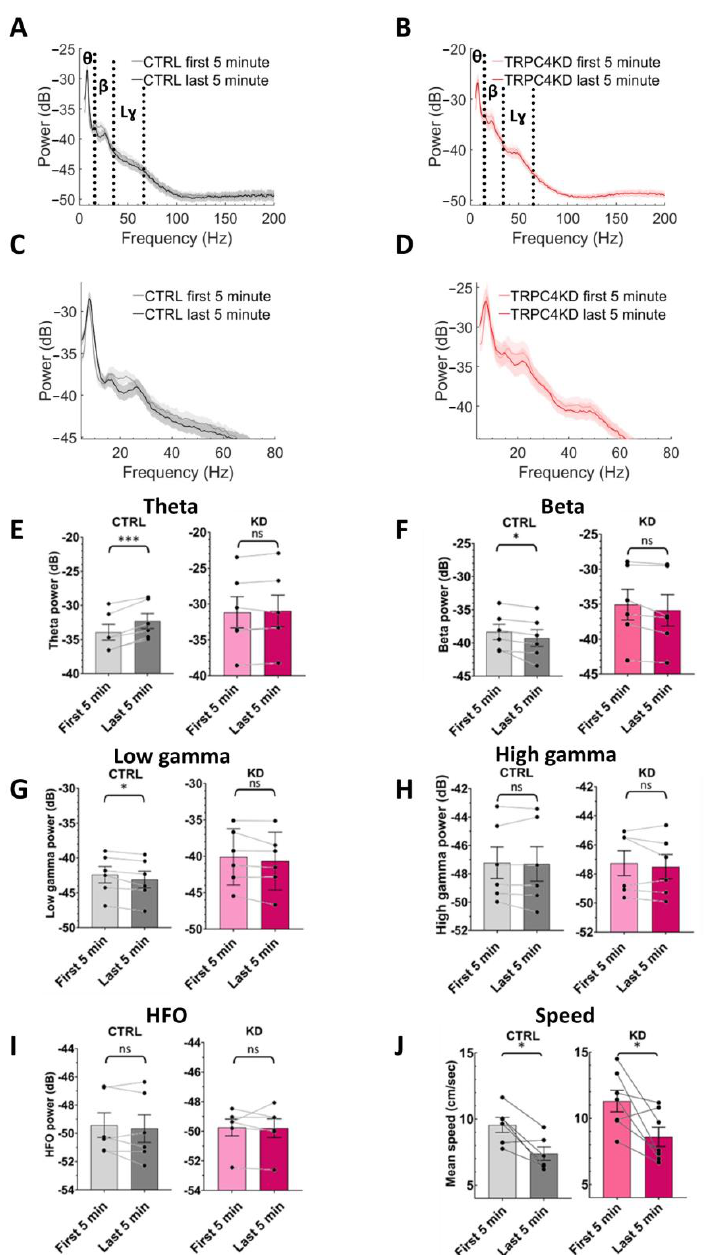
Figure 4. Comparison of the first and the last 5 min of the LT task. ( A ) Mean power spectra in the first 5 min and the last 5 min for scramble group. ( B ) Mean power spectra in the first 5 min and the last 5 min for TRPC4 KD group. ( C , D ) Rescaled power spectra shown in ( A , B ). ( E ) Theta oscillations (paired t -test, p < 0.001 for scramble and p = 0.305 for TRPC4 KD). ( F ) Beta oscillations (paired t -test, p < 0.05 for scramble, p = 0.059 for TRPC4 KD). ( G ) Low-gamma oscillations (paired t -test, p < 0.05 for scramble. p = 0.134 for TRPC4 KD). ( H ) High-gamma oscillations (paired t -test, p = 0.630 for scramble, p = 0.419 for TRPC4 KD). ( I ) High-frequency oscillations (paired t -test, p = 0.371 for scramble, p = 0.873 for TRPC4 KD); HFO: high-frequency oscillations. ( J ) Mean of speed during the first 5 and last 5 min of the task (paired t -test, p < 0.05 for scramble, p < 0.05 for TRPC4 KD). ns, not significant. In all panels, scramble: n = 6; TRPC4 KD, n = 6. *: p < 0.05, ***: p <0.001, ns: not